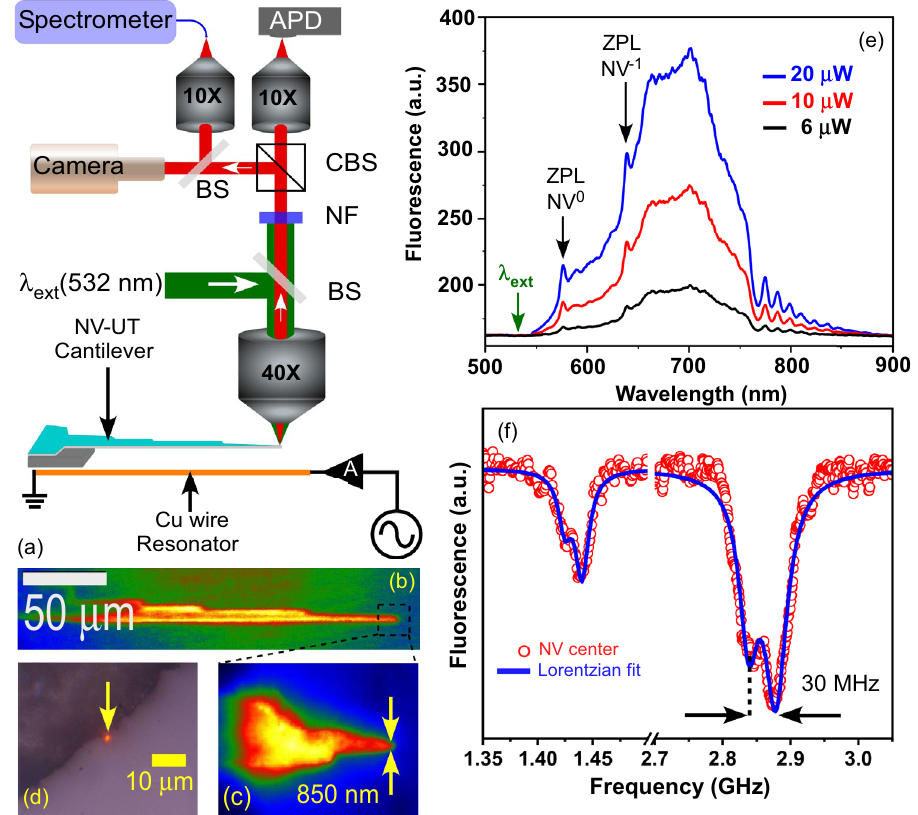
Figure 2. ( a ) Schematic setup for fluorescence imaging, fluorescence spectroscopy, and ODMR spectroscopy. APD Avalanche photodiode, BS Beam splitter, CBS Cube beam splitter, NF Notch filter, A Amplifier. ( b ) An EMCCD (electron-multiplying CCD) image showing NV fluorescence from the NV-UT cantilever under large-area illumination (green light). ( c ) Magnified fluorescence image of the cantilever tip. ( d ) Fluorescence image of the cantilever under local illumination of the green CW laser. ( e ) Fluorescence spectra of NV center on the cantilever tip under green CW laser (532 nm) excitation (6, 10, and 20 µW) show two zero phonon lines at 575 nm for NV 0 and 637 nm for NV −1 , respectively. ( f ) ODMR spectra were recorded while varying the microwave frequencies from 1.35 to 3.1 GHz. A dip in fluorescence intensity at 1.43 and 2.87 GHz was